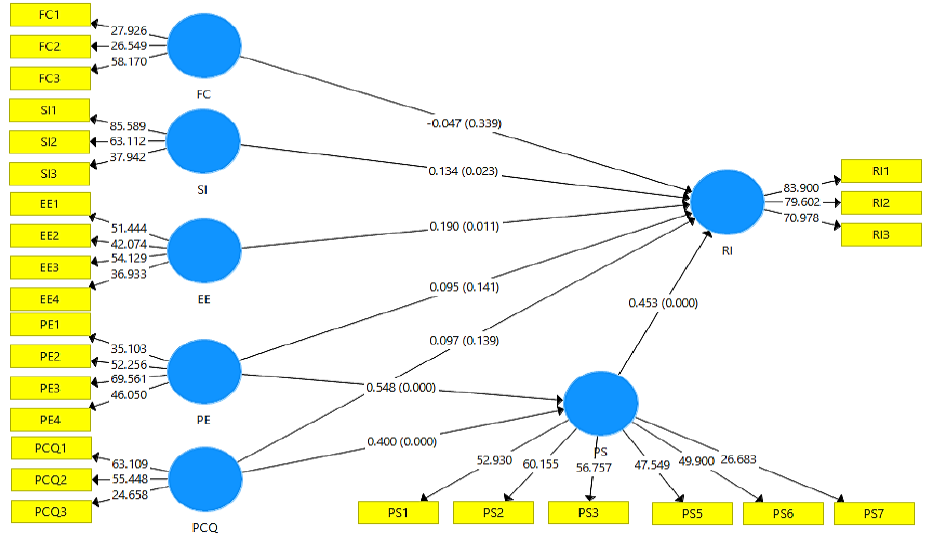
Figure 2: Hypotheses